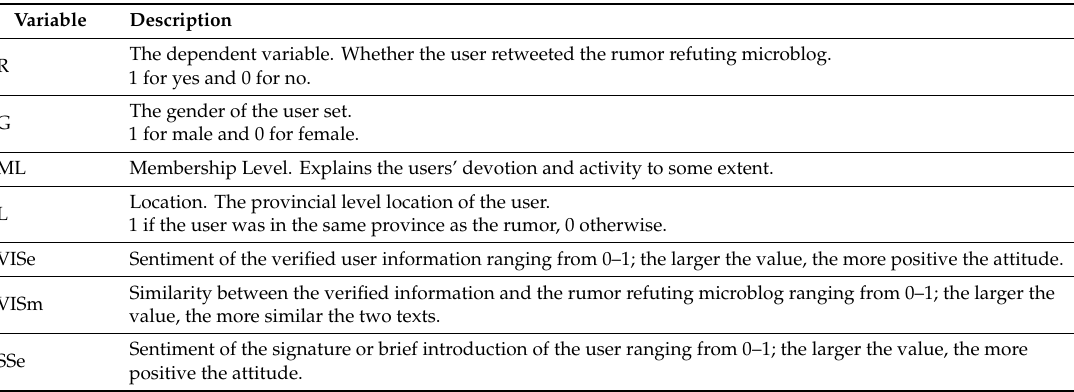
Table 1. Research